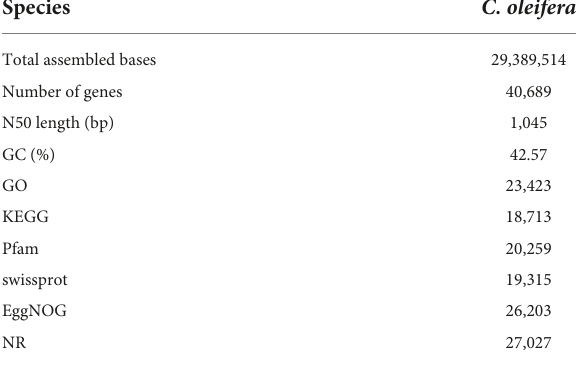
TABLE 1 Summary of Illumina transcriptome sequencing for Camellia oleifera.